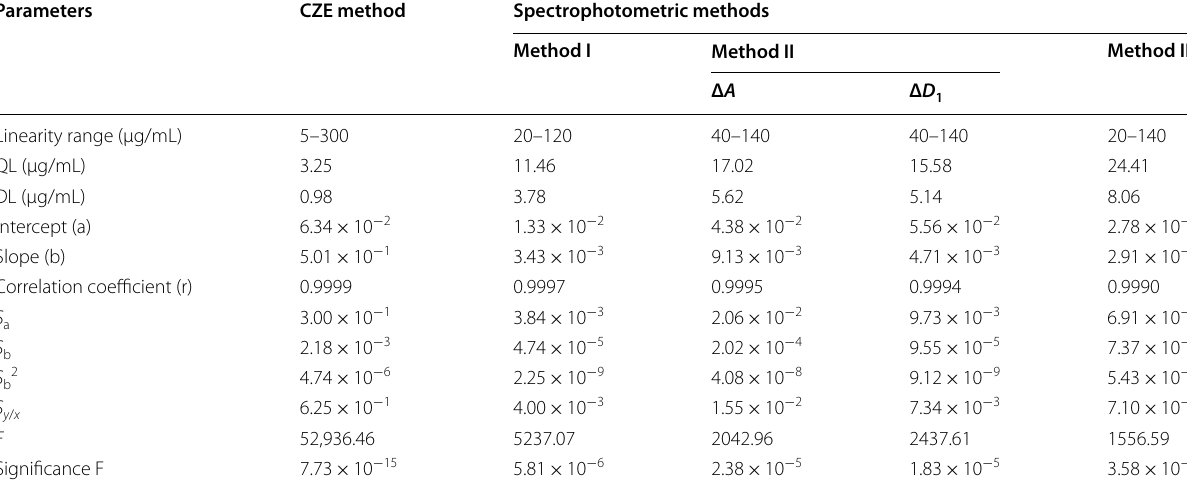
Table 2 Analytical parameters for the quantification of TIG in intravenous infusion solution